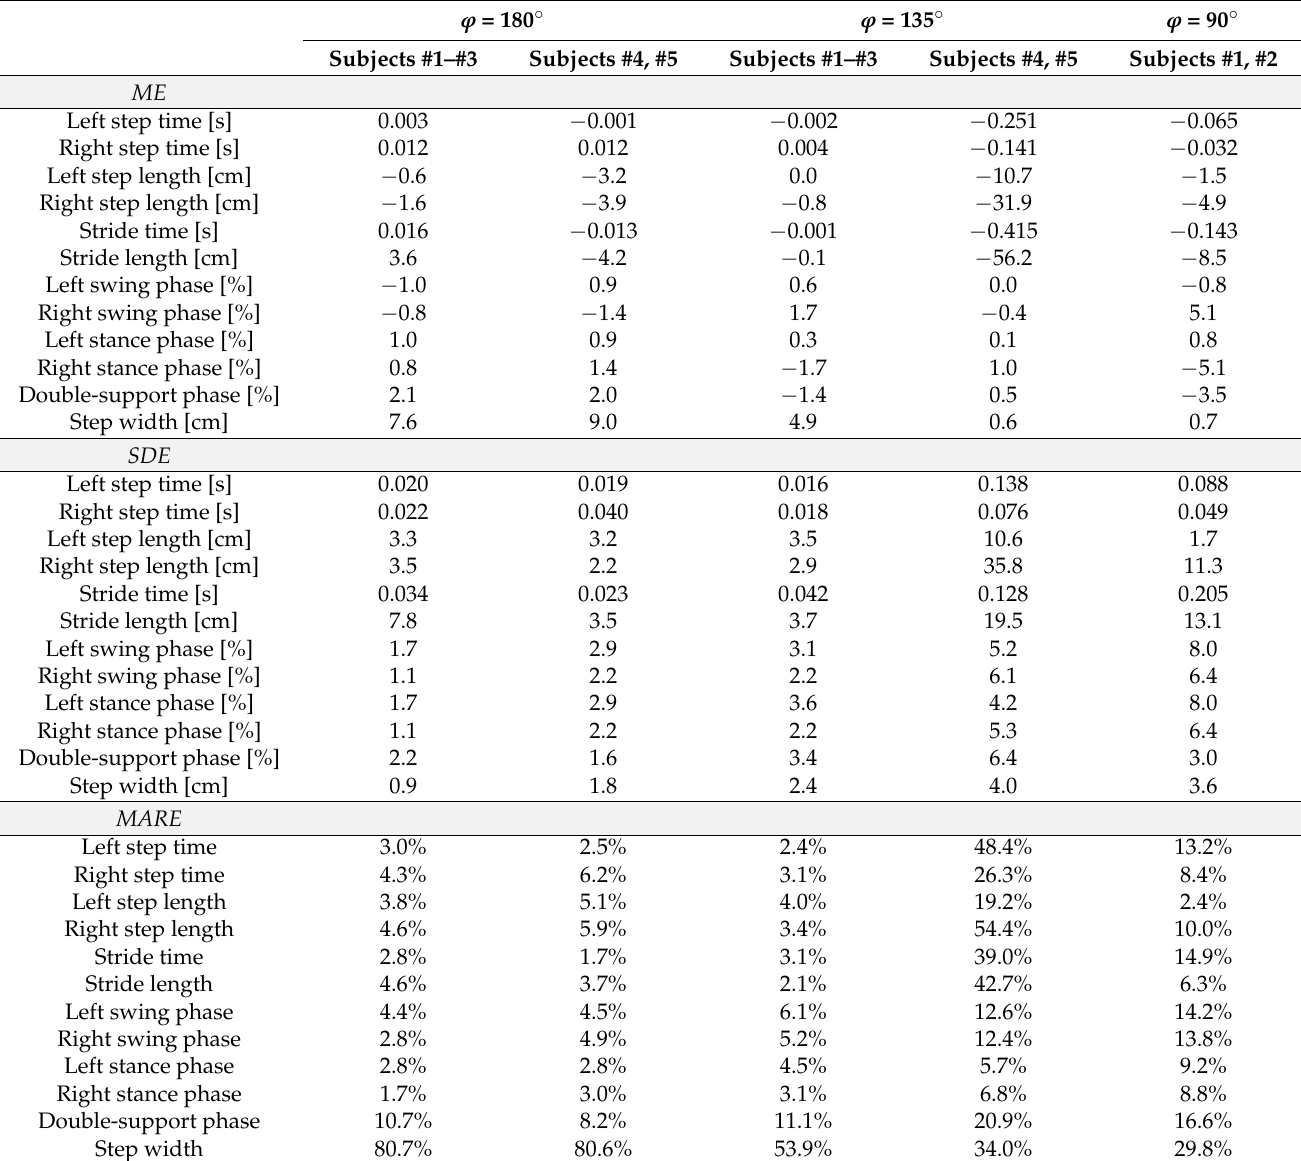
Table A4. The indicators of accuracy of the estimates of spatiotemporal gait parameters, obtained using the FV